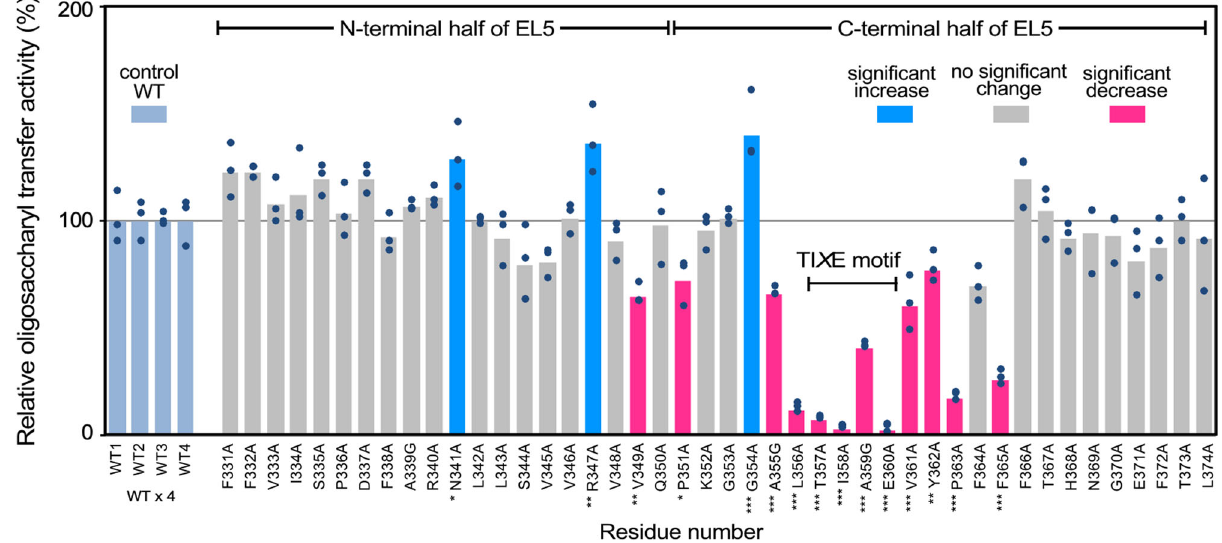
Fig. 3 Alanine scanning mutagenesis of the EL5 loop. The bar heights indicate the mean values of triplicate measurements in the oligosaccharyl transfer assay. Statistical analyses were conducted by one-way ANOVA followed by Dunnett ’ s two-sided post-hoc test between each mutant and the corresponding wild type on the same PAGE gel. A total of 4 gels were used (Supplementary Figs. 2, 7, and 8). Adjusted p values of 0.05 or less were considered statistically signi fi cant. *adjusted p < 0.05, ** <0.01, *** <0.001. The magenta bars represent the amino acid residues with a signi fi cant decrease, the blue bars represent those with a signi fi cant increase, and the gray bars represent those with no signi fi cant changes of the oligosaccharyl transfer activity upon mutation, whereas the pale blue bars represent the control reference of the wild-type